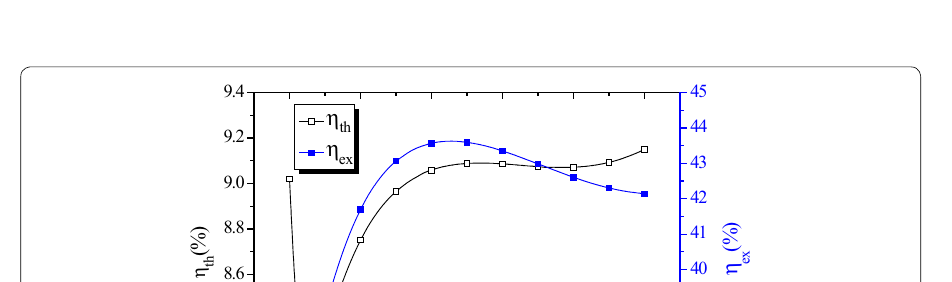
Fig. 2 Validation of the simulation model